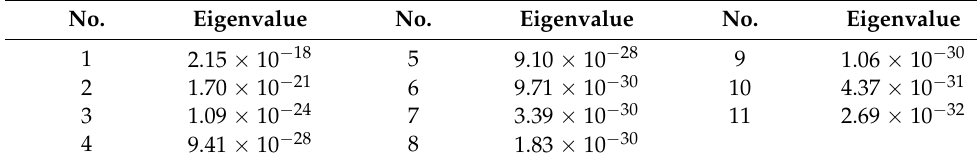
Figure 12. Scattered signal of two close damage. Table 3. Eigenvalue of two damage with distance less than half ‐ wavelength.